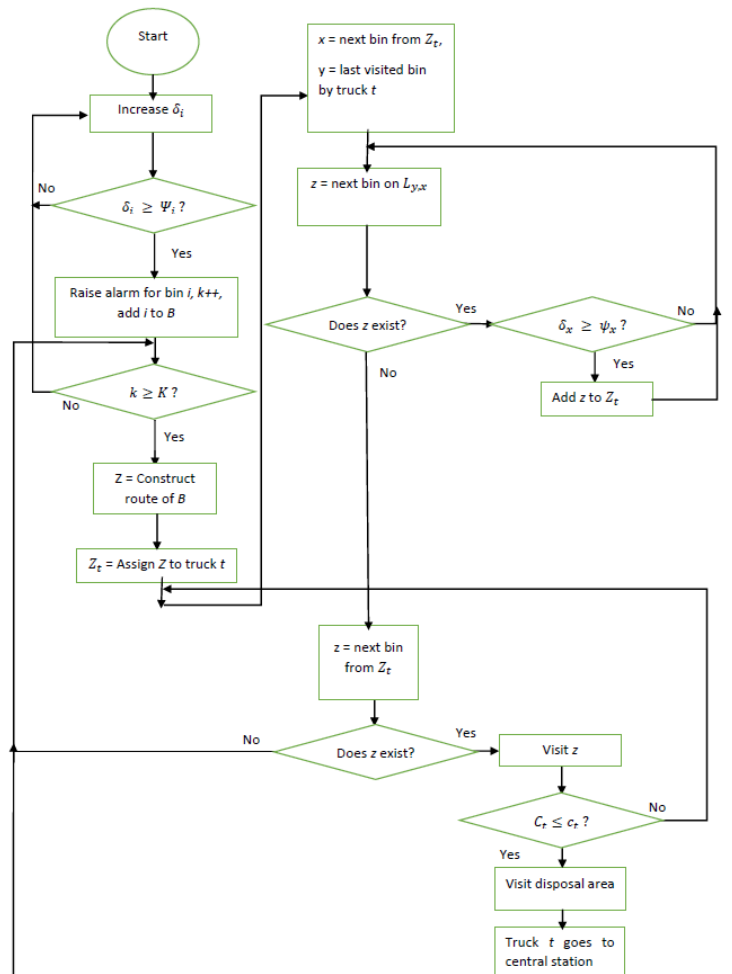
Figure 4. Collect based on Upper and Lower Threshold (CULT)